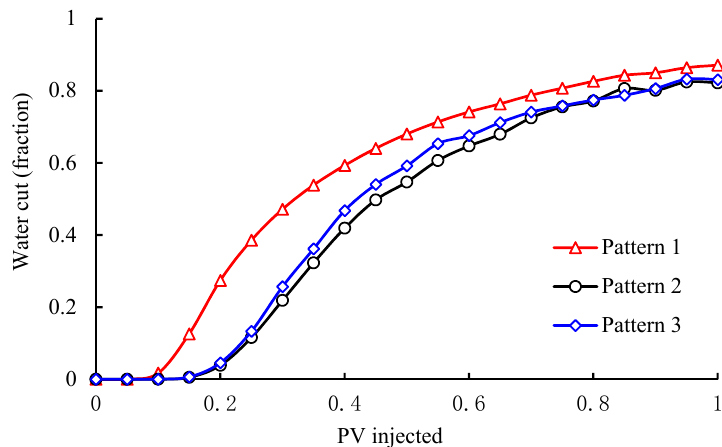
Energies 2019 , 12 , x FOR PEER REVIEW Figure 12. Water cut variation under different fracture length patterns. Figure 12. Water cut variation under di